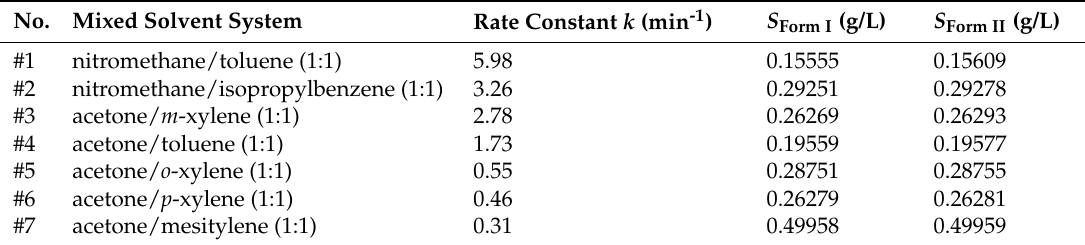
Table 4. The rate constant and solubility data of Form I and Form II in experiments at 30 ◦